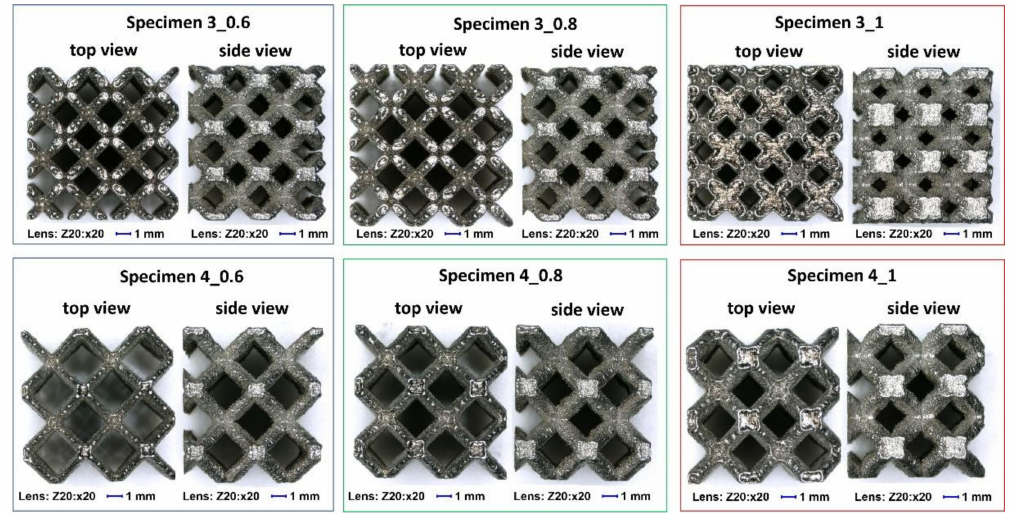
Figure 5. Digital microscope photographs of the top and side views of the lattice structure specimens (magnification ×